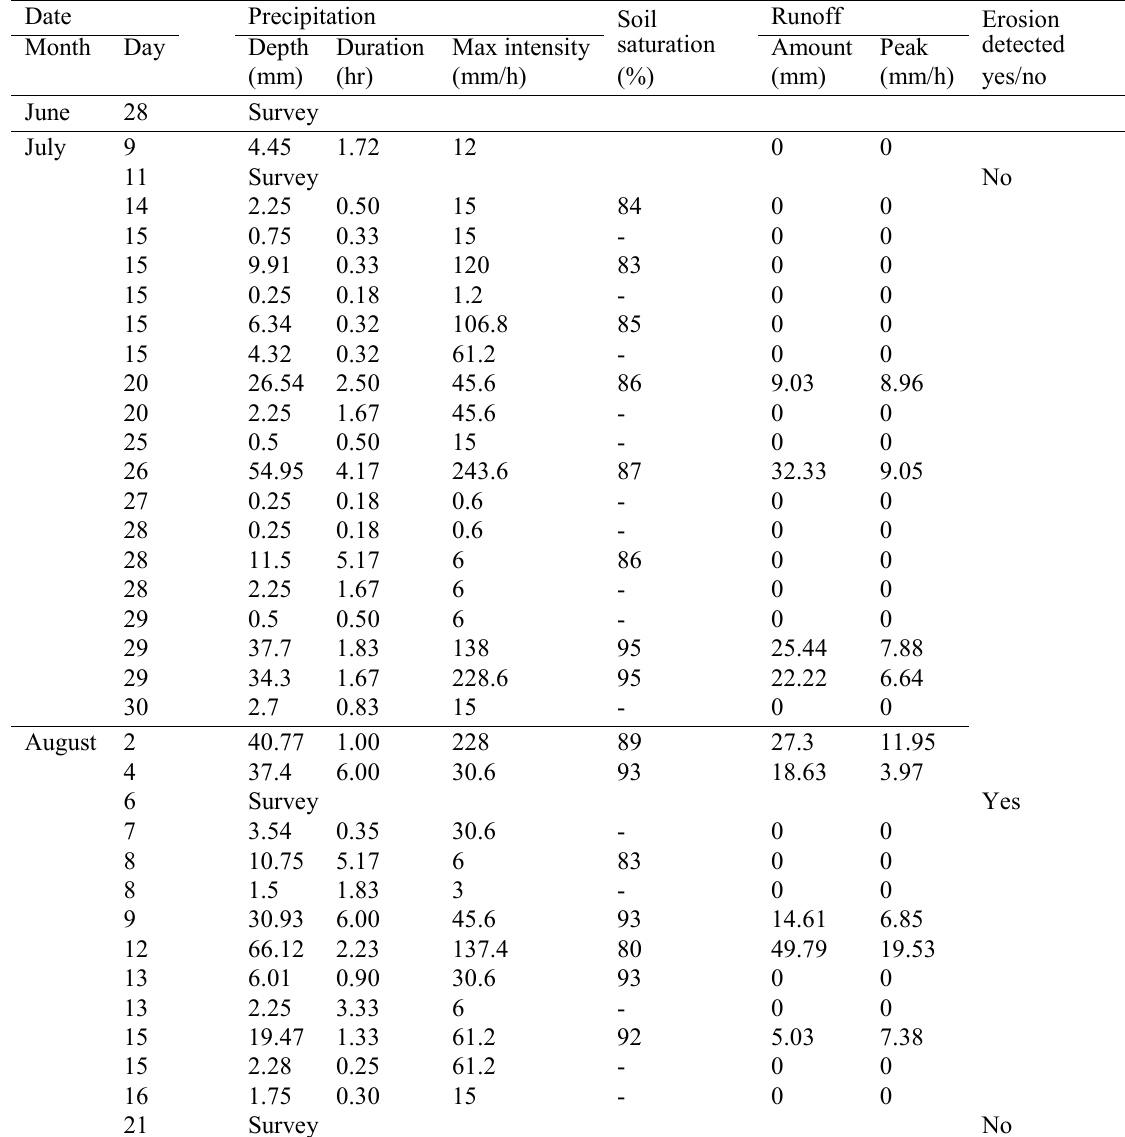
Table 1 Hydrologic characteristics for all events during summer of